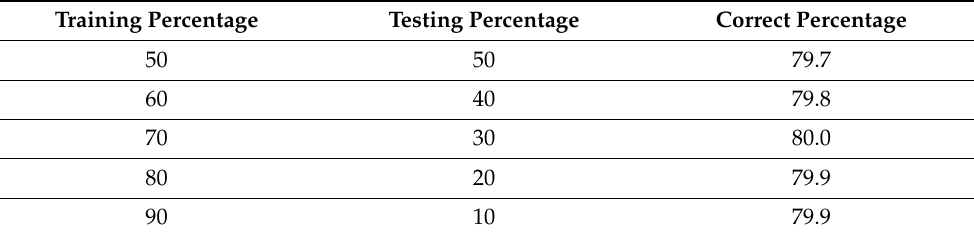
Table 3. Evaluation of the correct prediction percentage of rainfall and non-rainfall events with different percentages of testing and training